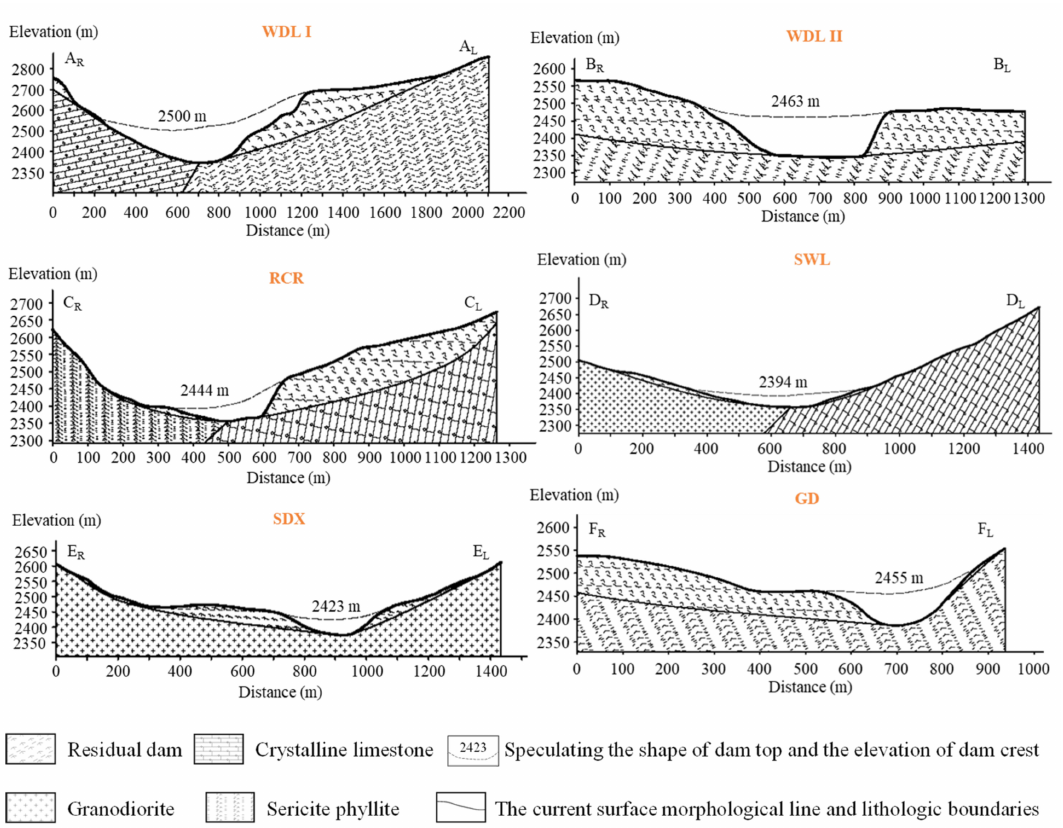
Figure 6. Speculative profile of each